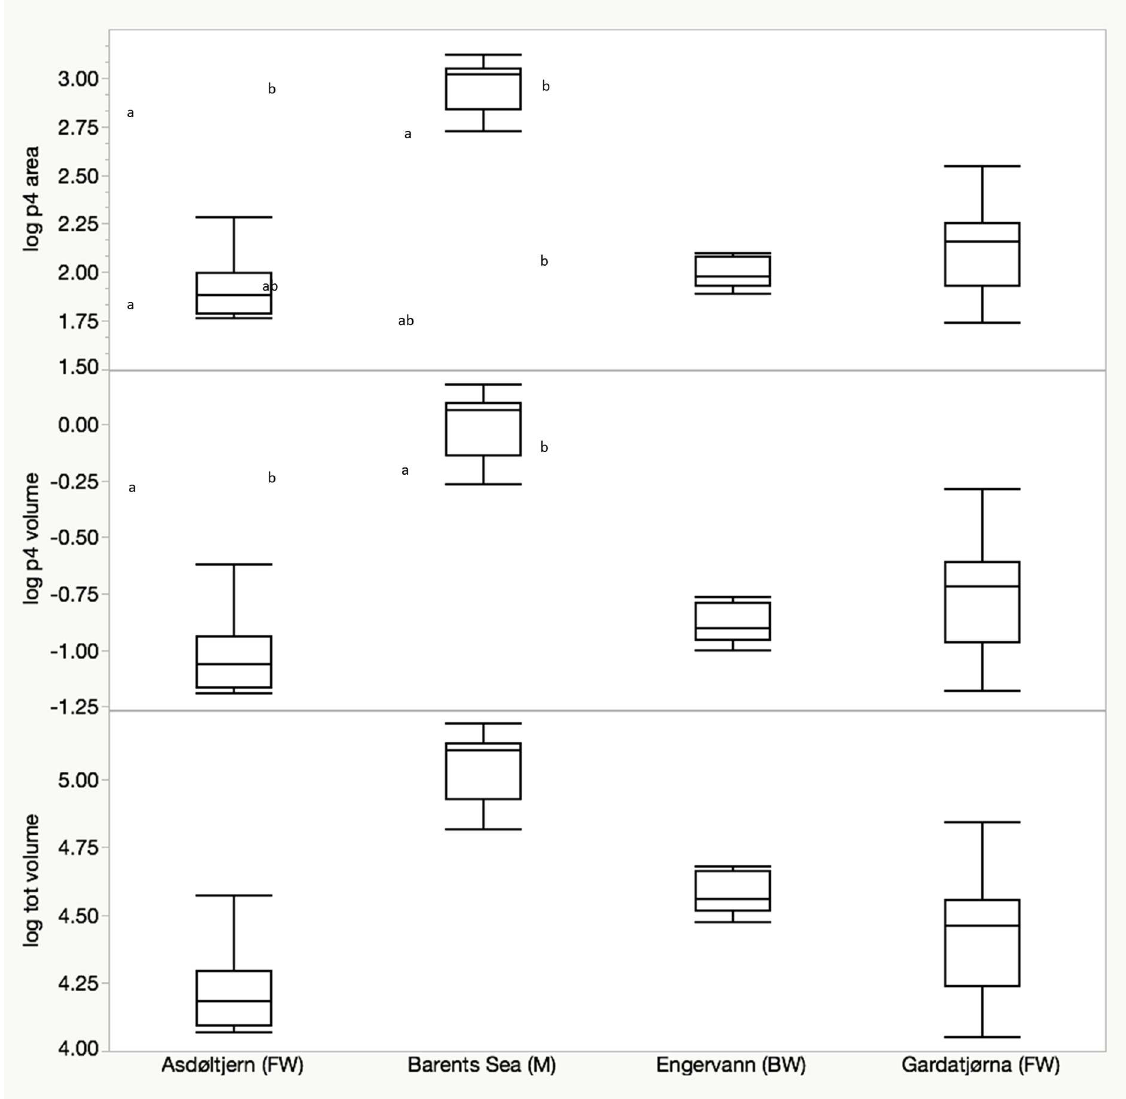
Fig 2. Among-population variation in lateral plate quality among complete plate stickleback. Box-plot of log-transformed predicted trait values (total lateral plate volume (mm 3 ), volume (mm 3 ) and area (mm 2 ) of lateral plate no 4) from Asd ø ltjern (FW), Barents Sea (M), Engervann (BW) and Gardatj ø rna(FW). Different letters indicate significant differences based on Tukey HSD